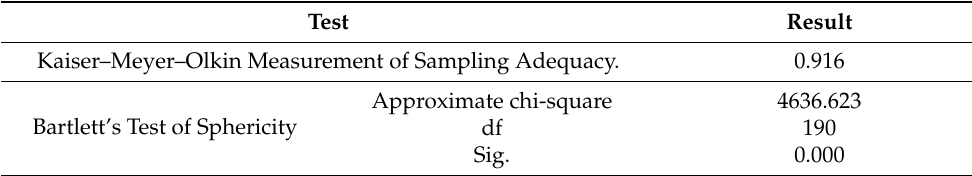
Table 5. Inspection of KMO and Bartlett. Test Result Kaiser–Meyer–Olkin Measurement of Sampling